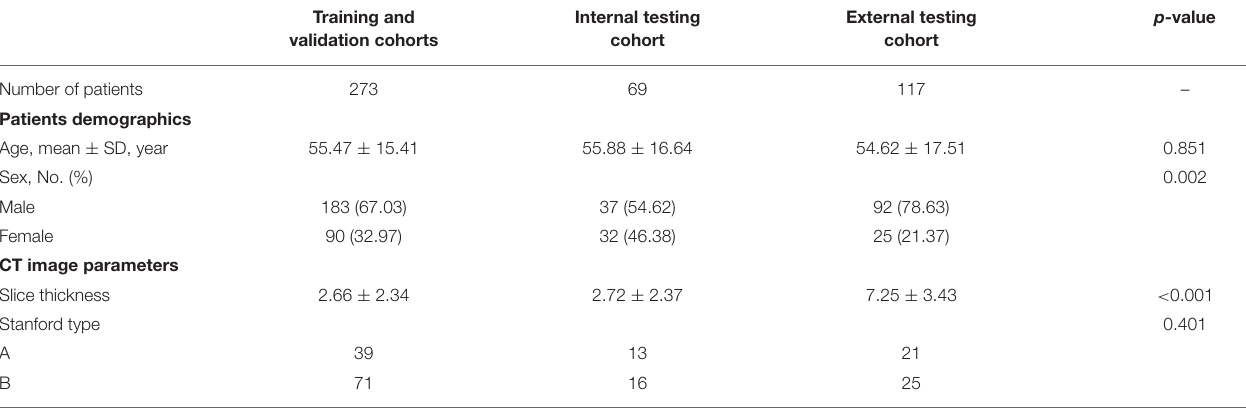
TABLE 1 | Demographics of patient and CT image parameters in all the